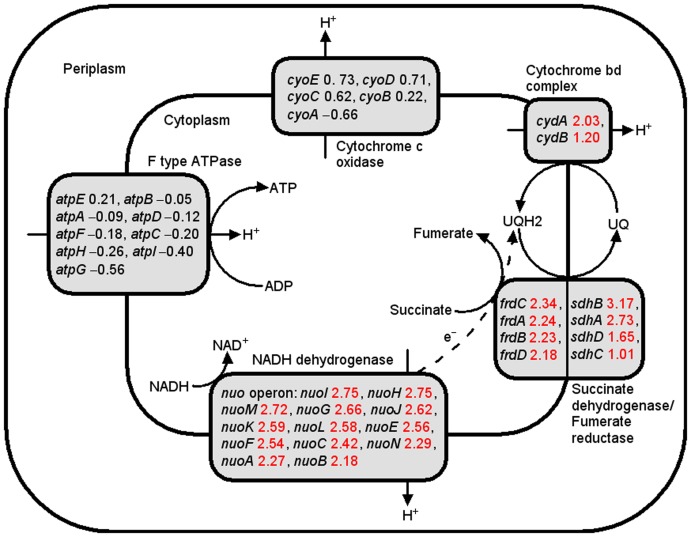
Differentially expressed genes associated with oxidative phosphorylation.The number after each gene is the Log2 value (fold change in E1 compared with E0). Red values: upregulated in E1; black values: no difference in expression; dashed arrows: direction of electron flow.